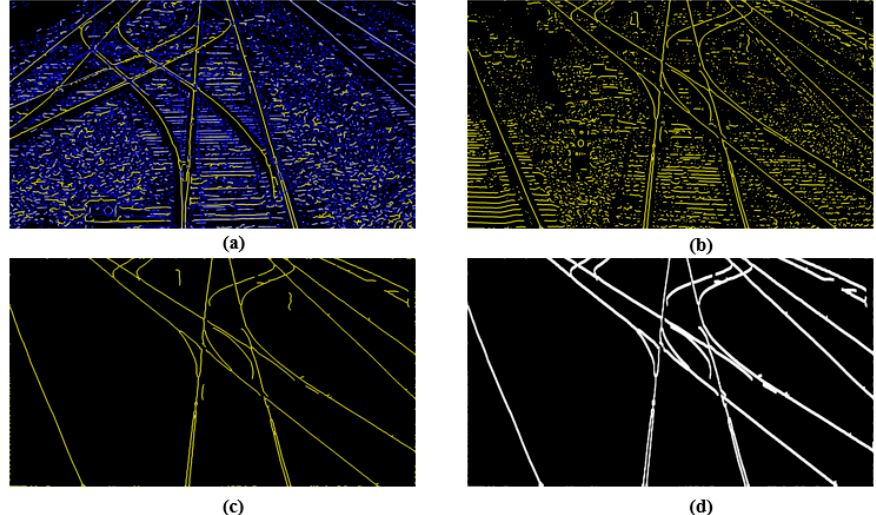
Figure 12. Effect of Denoising Algorithm. ( a ) is the minimum circumscribed rectangle of all profiles. ( b ) is the results of the improved ZS algorithm processing. ( c ) is the results of the denoising algorithm processing. ( d ) is the results of track line extraction.